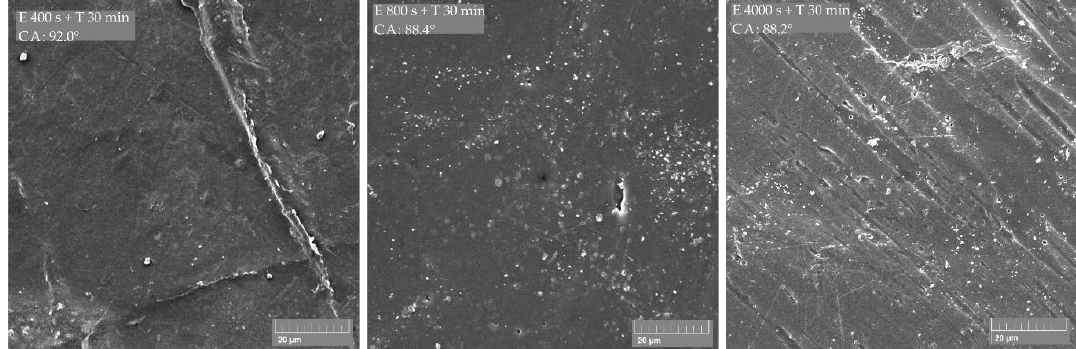
Figure 11. SEM micrographs of untreated ABS / PE-LD 90 / 10 polymer blend and treated by etching (E) and CF x coating (T); measured contact angle is indicated as